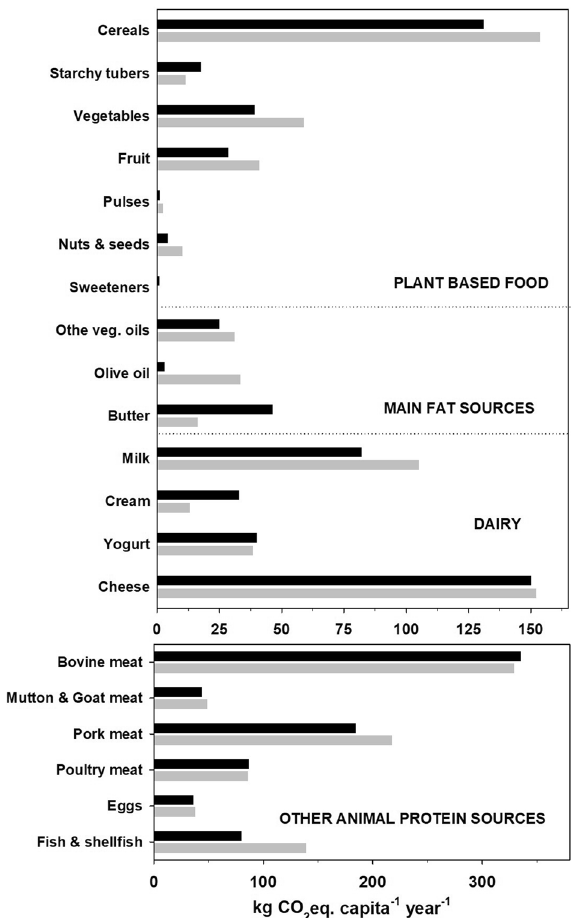
Figure 1. Annual per capita E GHG (kg CO 2 eq. capita −1 yr −1 ) associated with food consumption of EU citizens. E GHG of food groups refer to the weighted mean food consumption of Mediterranean citizen (7MED, grey bars) and other EU countries (21OTHER, black bars) in 2017.